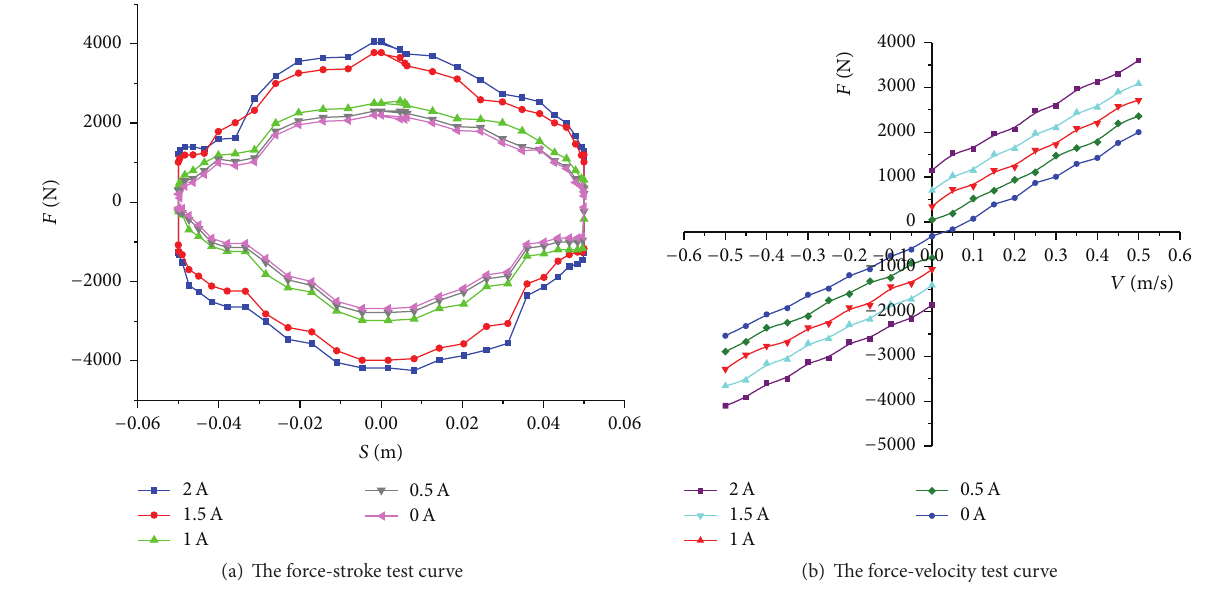
Figure 8: The test curve of MRD with annular radial